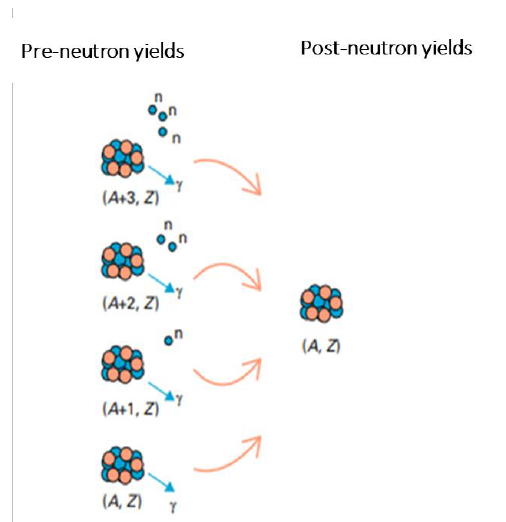
Fig. 1. Transition between pre-neutron data and post-neutron data